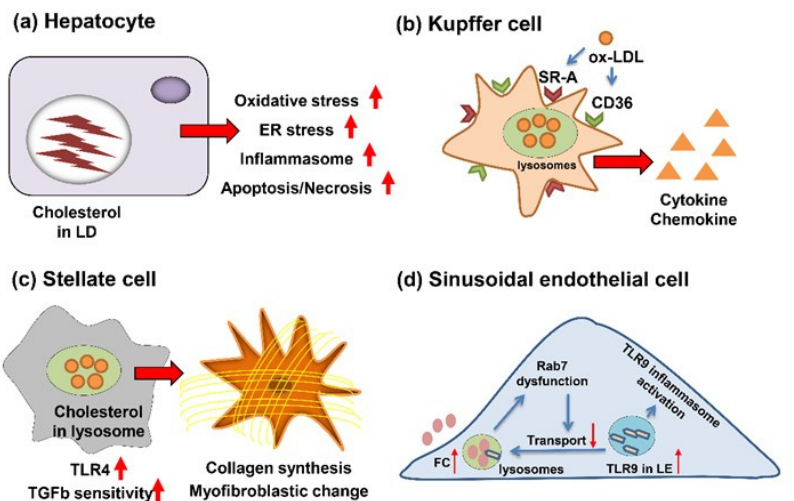
Figure 1. Impacts of dietary cholesterol on various cells in the liver. ( a ) In hepatocytes, accumulated free cholesterol enhances the progression of fibrosis through various damages. LD, lipid droplet; ER, endoplasmic reticulum. ( b ) In Kupffer cells, oxidized LDL is internalized by SR-A and CD36 and then pro-inflammatory and pro-fibrogenic cytokines and chemokines are secreted. ( c ) In hepatic stellate cells, intracellular cholesterol stimulates the stellate cell activation, mainly due to the increased TLR4 receptor levels and elevated sensitivity to TGF β . ( d ) In hepatic sinusoidal endothelial cells, increased free cholesterol (FC) in lysosomes attenuates the degradation of TLR9 and then activates the TLR9/inflammation pathway. LE, late endosome. Arrows: ↑ , Increased; ↓ , Decreased.